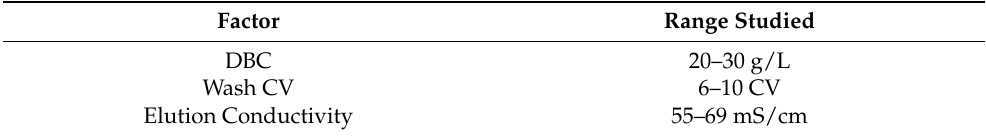
Table 2. Factors studied using CCF DoE design to determine optimal